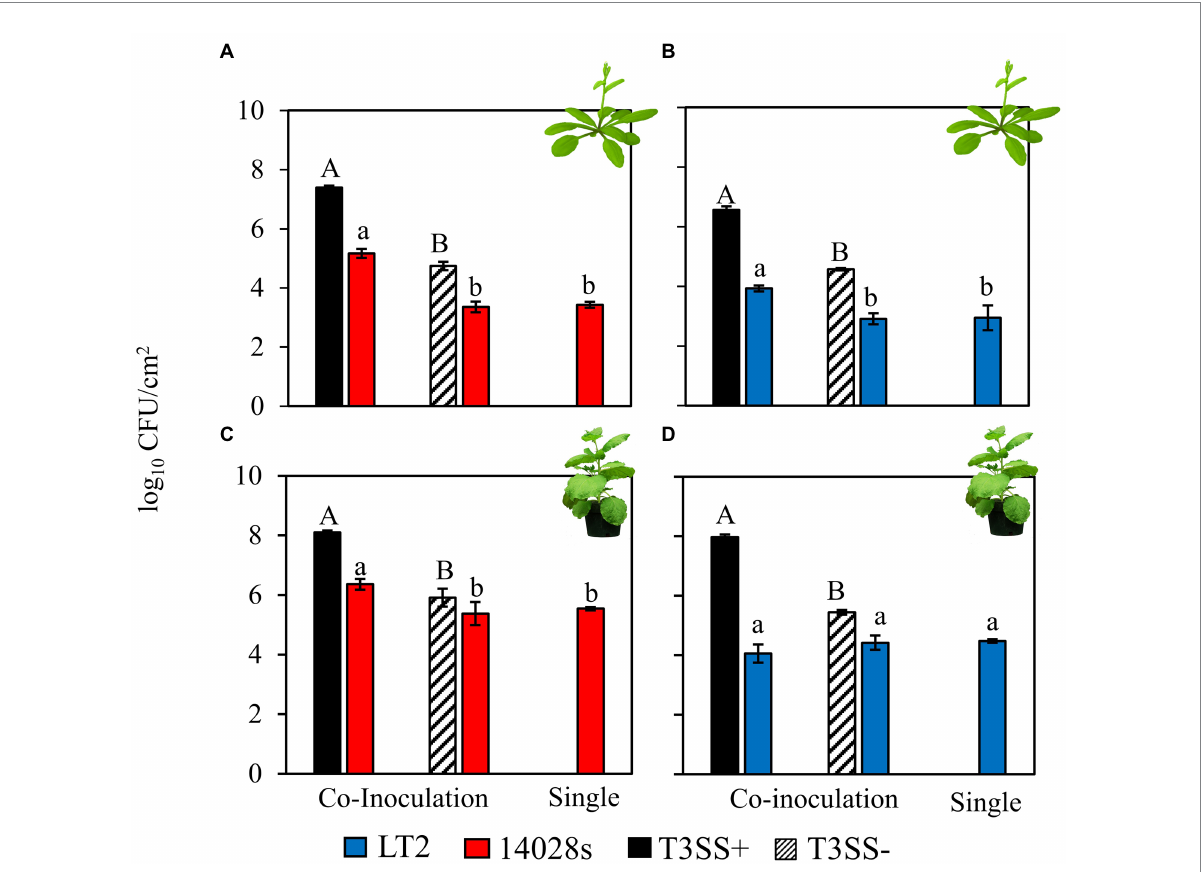
FIGURE 1 Salmonella enterica LT2 has a host-dependent defect in co-colonization of the Nicotiana benthamiana apoplast during P. syringae disease. Bacterial populations of S. enterica strains (A,C) 14028s (red), and (B,D) LT2 (blue) with co-inoculation partner P. syringae ( Pto ) or Pto ∆ hopQ with a functional Type III Secretion System (T3SS+, black) and Pto ∆ hrcC without a functional T3SS (T3SS − , striped) Inocula were syringe infiltrated into model plant hosts, (A,B) A. thaliana Col-0 at a concentration of 5 × 10 6 CFU mL − 1 for Pto strains and 5 × 10 5 CFU mL − 1 for S. enterica strains and (C,D) N. benthamiana at a concentration of 5 × 10 5 CFU mL − 1 for all strains. Bacterial populations were measured as log colony forming units per cm 2 of leaf tissue